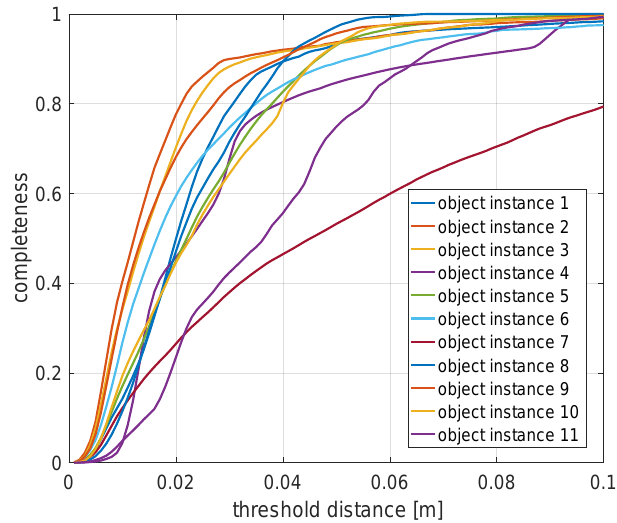
Figure 18. Detailed shape completeness measures as a function of the threshold distance. The area-under-curve serves as a final measure to evaluate the completeness and quality of all 11 object